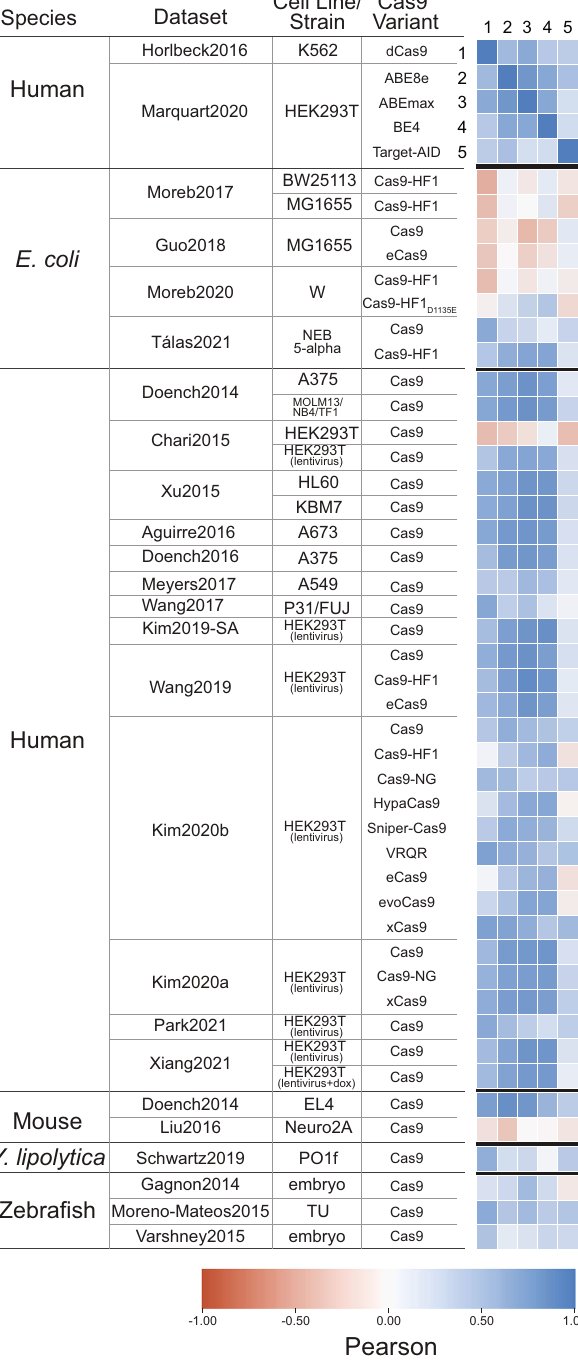
Fig. 6 Nuclease null Cas9 variants have similar sequence preferences in the PAM proximal 2 bp. Using a dCas9 dataset from Horlbeck et al. 2016 39 and base editing datasets from Marquart et al. 2020 40 , we grouped gRNA by the PAM proximal 2 bp, averaged activity and correlated the grouped averages with the datasets from Fig.